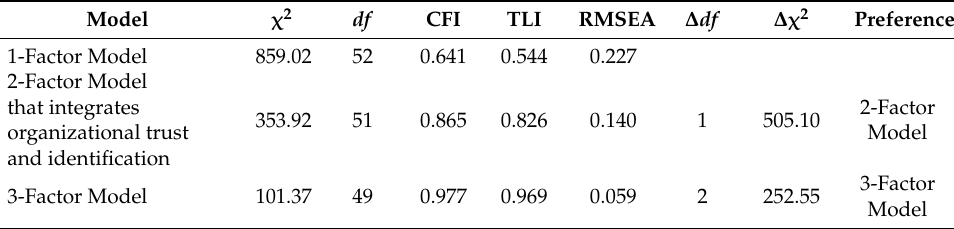
Table 3. The chi-square difference tests among the alternative measurement models.